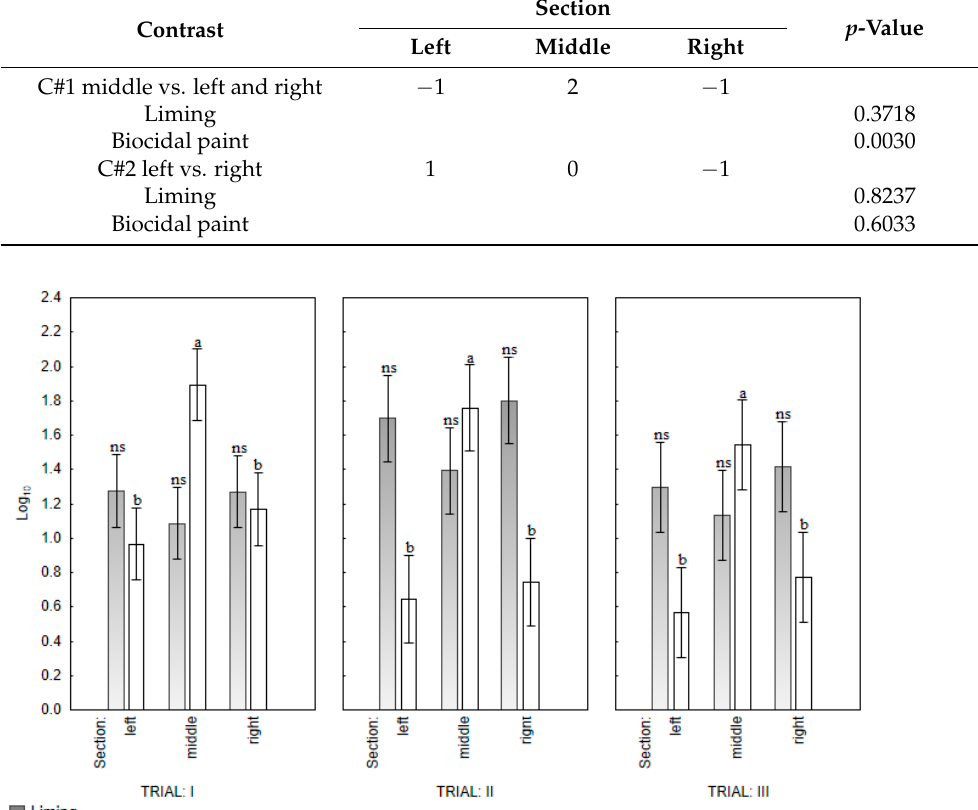
Figure 2. Location of Alphitobius diaperinus in different sections of poultry houses in each trial. Different lowercase letters indicate significant differences ( p < 0.05); ns—no significant differences between trap sections. The standard error of the mean (SEM) is indicated on the bar.